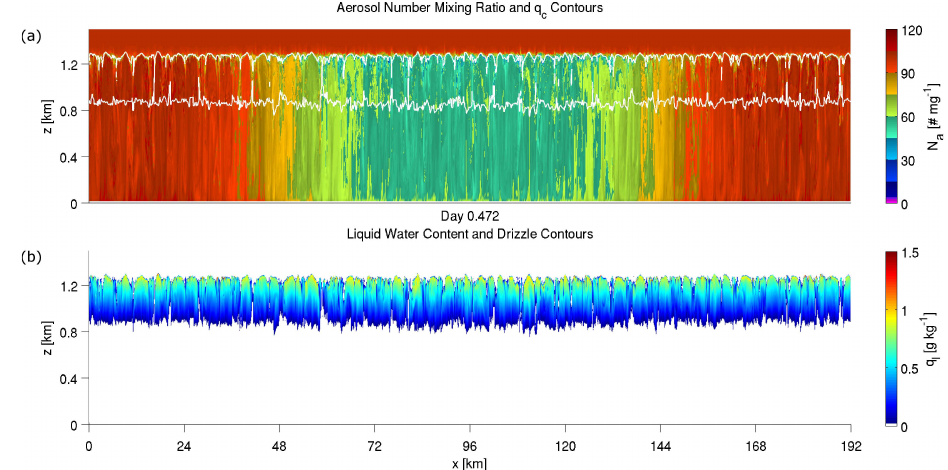
Fig. 12. x – z sections from W5/NA100:50-POC at day 0.47. (a) Aerosol number concentration N a with the 0.01gkg − 1 q c contour.